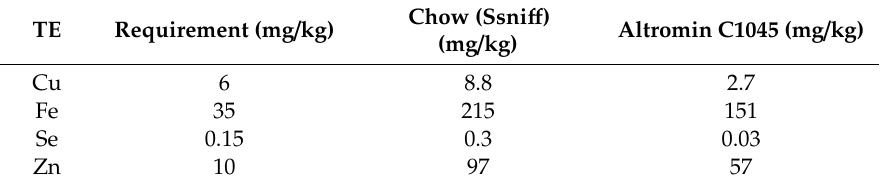
Table 2. Estimated trace element requirements of mice [30] and trace elements in the diets used.